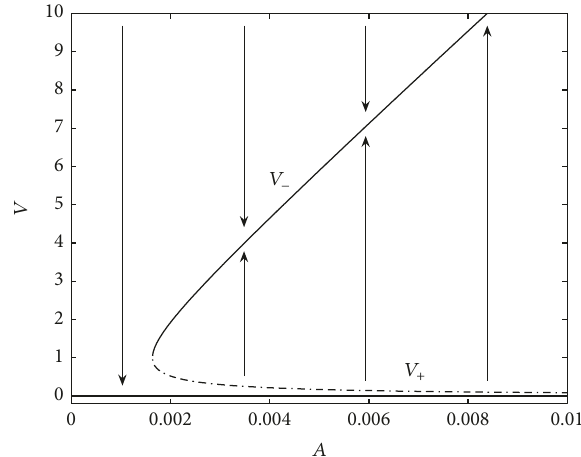
Figure 1: Bifurcation diagram for variable 𝑉 and parameter 𝐴 . The solid curve describes the stable stationary state 𝑉 − and the dashed curve describes the unstable stationary state 𝑉 + . The arrows denote the state which the system tends to